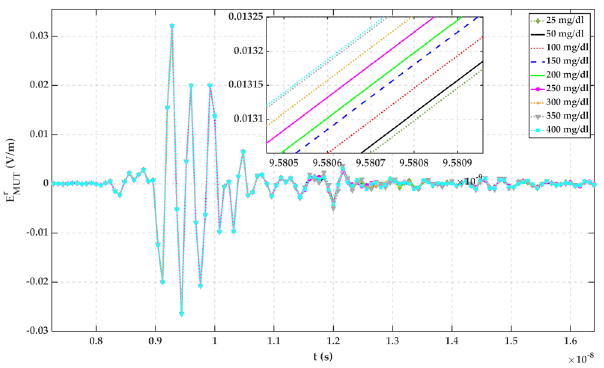
Figure 9. Transformed TD reflected signals regarding different MUTs (measured with PNA-X).